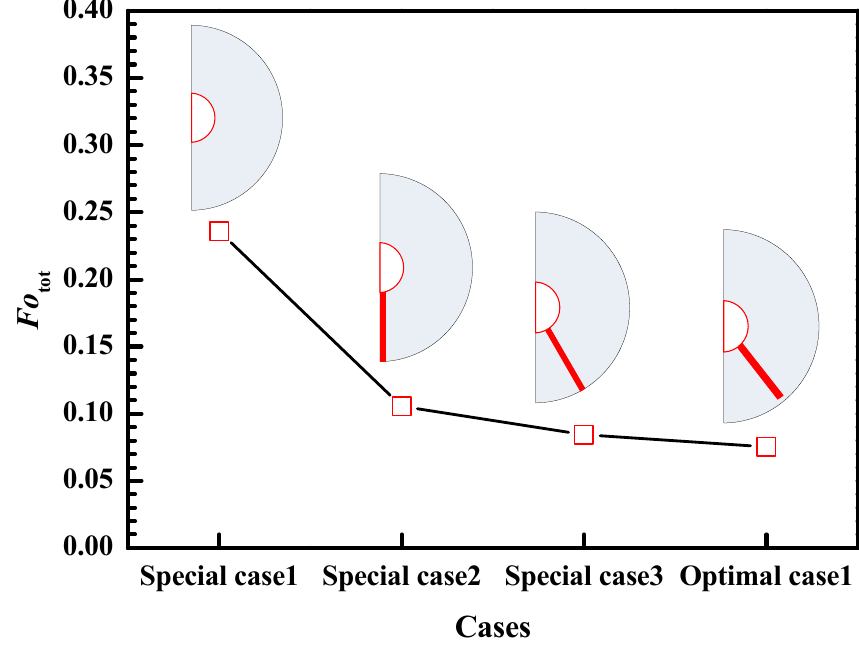
Figure 8. Dimensionless total melting time, Fo tot , for Special Cases 1–3 and Optimal Case 1.